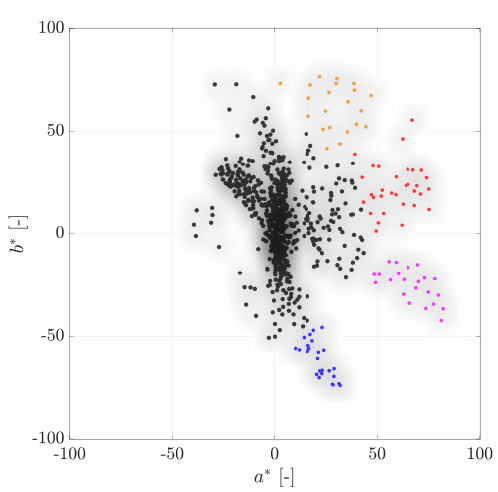
Figure 9. k -means clustering procedure to distinguish detections from background shown in in the a *- b * plane of the CIELAB color space. The values of the pixels of the training frames (gray-shaded heat map), the a ∗ and b ∗ components of the (L)AB color map C AB (dots) indicating the values of the color map which correspond to a detection of a colored hat (corresponding colors) and background (black).